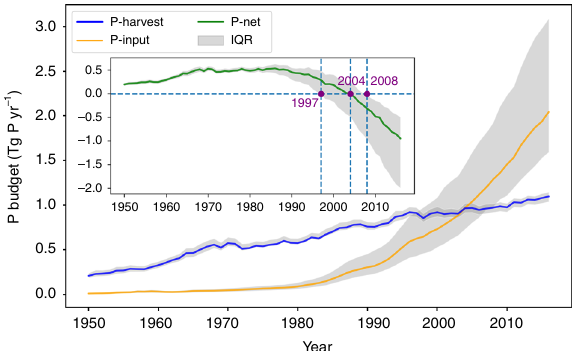
Fig. 2 Global fi shery phosphorus balance from 1950 to 2016. The blue line shows the average P-harvest fl ux from fi sh. The orange line represents the average P-input into aquatic ecosystems through aquaculture. The inset fi gure with the green line is the net P-net, i.e., P-harvest minus P-input. Light-gray shading indicates interquartile ranges (IQR, the 75th and 25th percentiles) calculated from 1000 estimates with randomly sampled fi sh P concentration, fi sh biomass within 50% percentile uncertainty for P- harvest, and culture-system level P-use ef fi ciency for P-input. Units are Tg P yr − 1 . Source data are provided as a Source Data fi